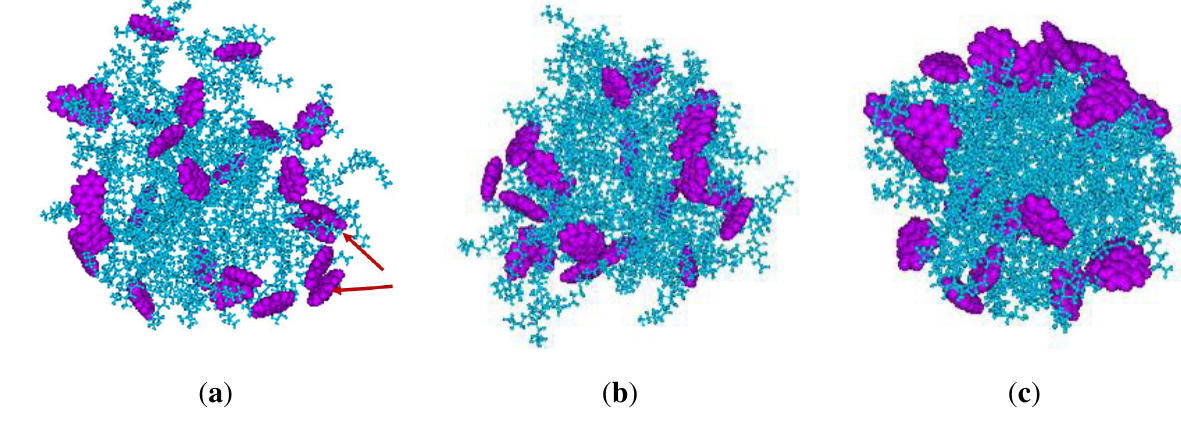
Figure 2. Representative images of G5-PAMAM dendrimer with 25 of phenanthrene molecules after 1 ns as an atomistic molecular dynamics: ( a ) low pH ( b ) neutral pH ( c ) high pH. The dark red arrows indicate the stacked Phe molecules. Reproduced from Ref. [24] with permission from the PCCP Owner Societies.